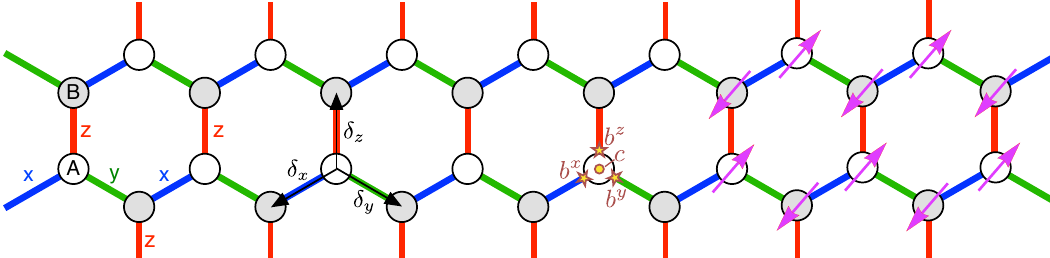
Figure 2: The Kitaev honeycomb model on a lattice. The unit cell with sites A and B is shown, together with the three inequivalent bonds labeled α = x , y , z . The vectors δ α indicate the nearest neighbor position relative to an A site. In the middle of the lattice I indicate how a spin can be split up into four Majorana operators b α and c . On the right a visualization of the initial Néel